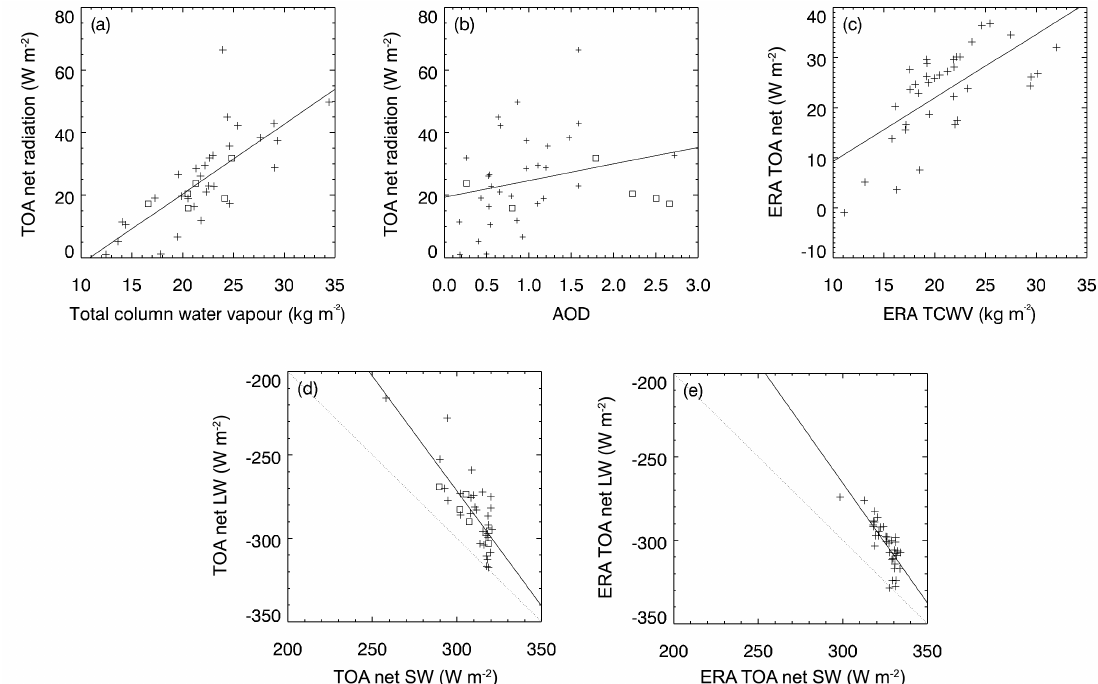
Figure 2. TOA fluxes, with symbols as in Fig. 1, showing daily means for days with surface data. Dotted lines in (d) and (e) have a gradient of −